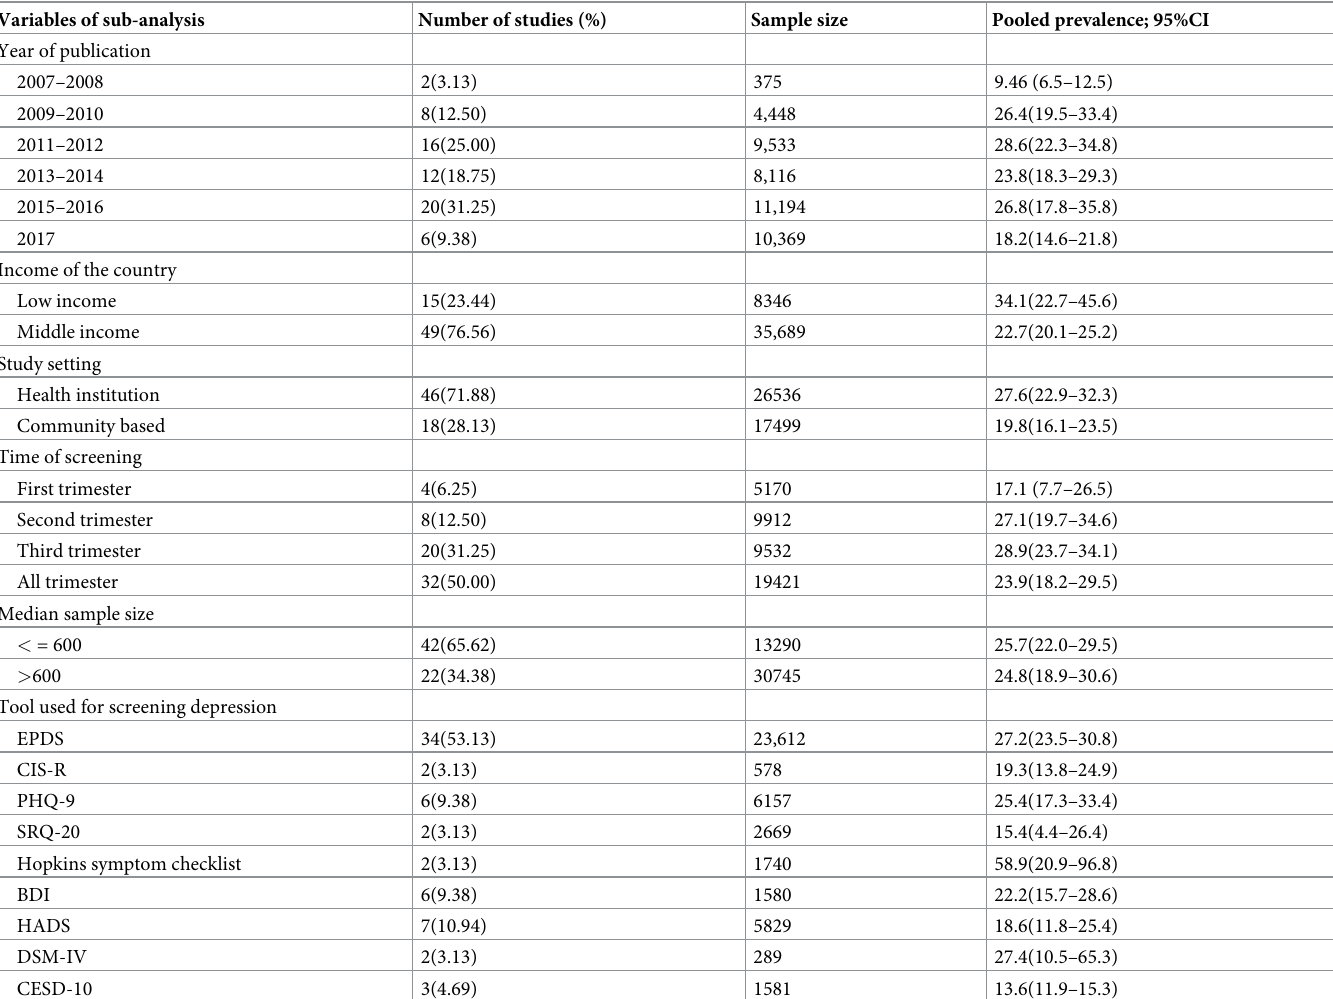
Table 2. Sub-analysis of antenatal depression prevalence in the low- and middle-income countries (N = 64, 2007–2017), (random effect model). Variables of